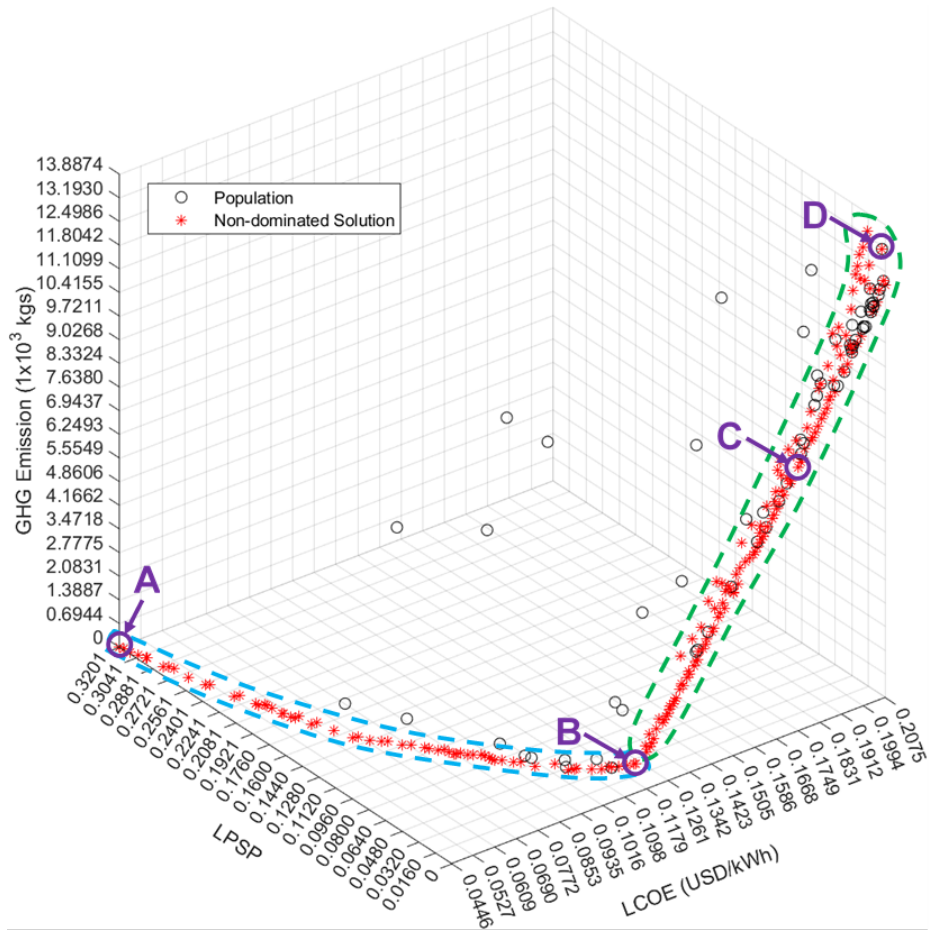
Figure 13. Multi-objective optimization frontier solution set of MOPSO.